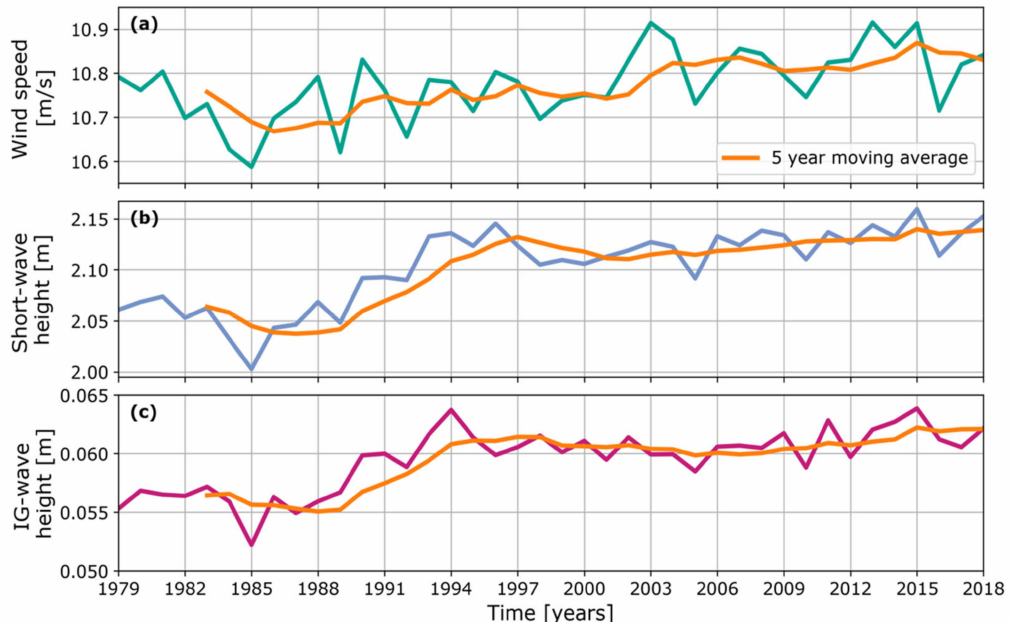
Figure 9. Identifying the driving conditions behind the global trends based on the annual 95th percentiles of the metocean parameters: ( a ) wind speed; ( b ) short-wave height; ( c ) IG-wave height; from 1979 to 2018. The orange line represents the 5-year moving